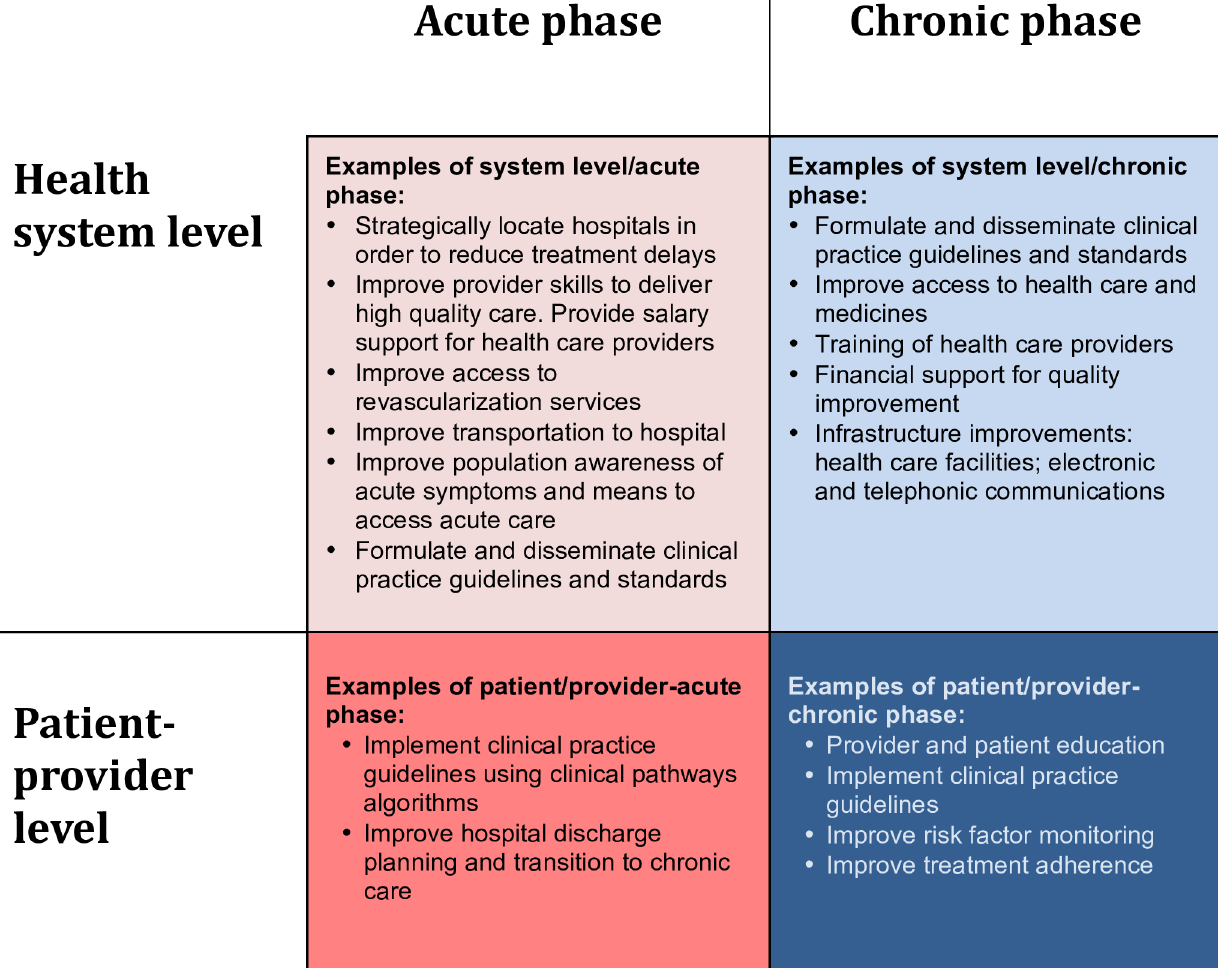
Fig 1. Quality conceptual framework for cardiovascular diseases, the